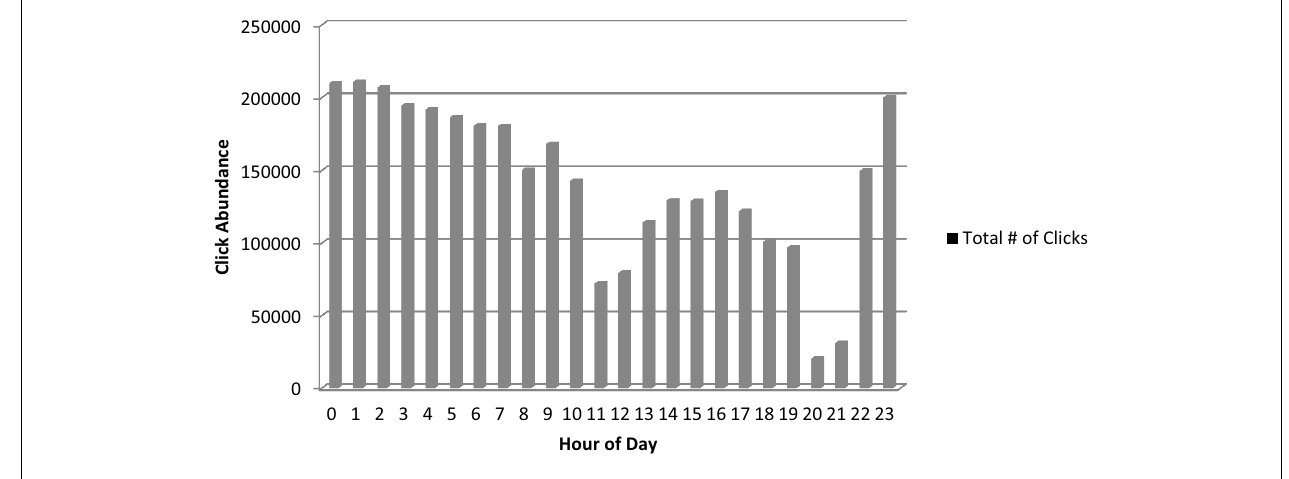
FIGURE 7 | Click occurrence at fixed hydrophone array during September 4–11, 2012 (0h refers to the time period between 12 and 1 a.m.) .